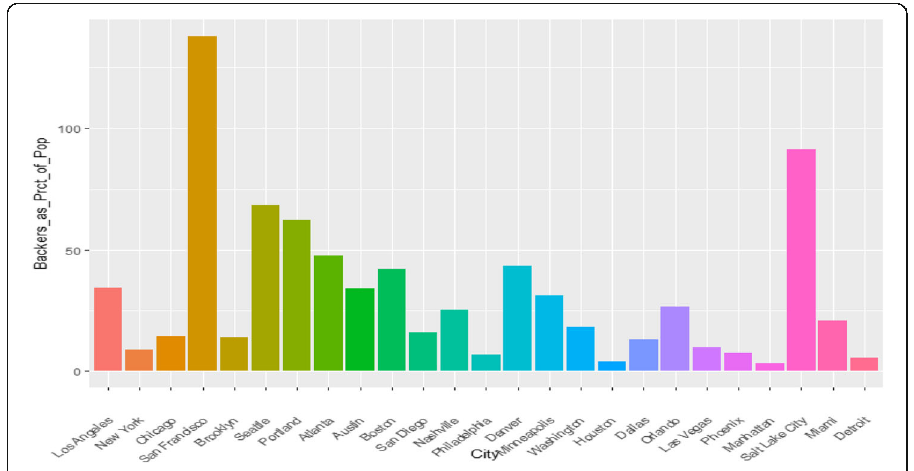
Fig. 9 Backers as a percentage of city population all